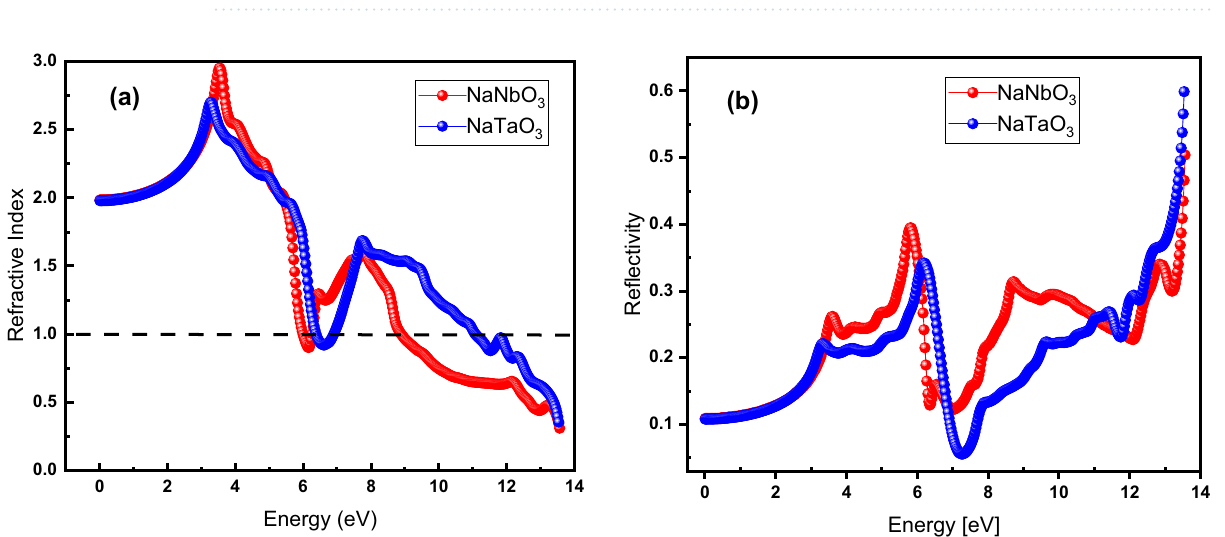
Figure 9. (Color Online) ( a ) refractive index and ( b ) reflectivity as a function of energy for NaNbO3 (red) and NaTaO3 (blue) oxide